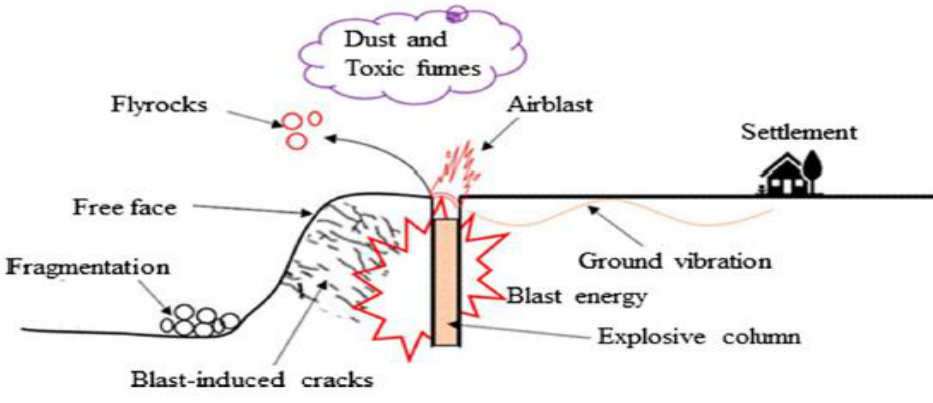
Figure 1. Blastwave propagation and its unwanted environmental events (adapted from [13]).